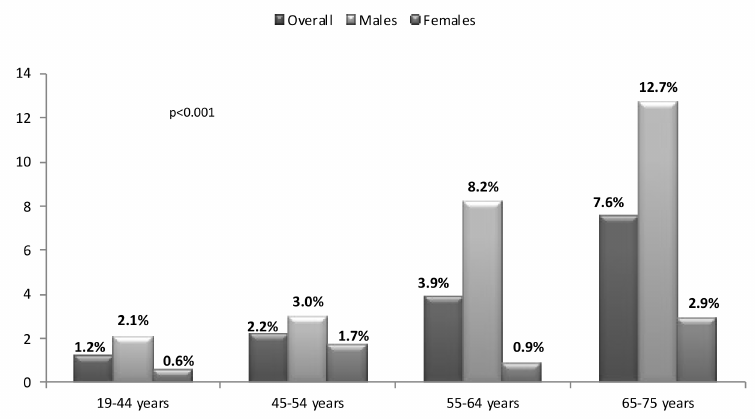
Figure 5. Prevalence of early kidney disease by age groups and